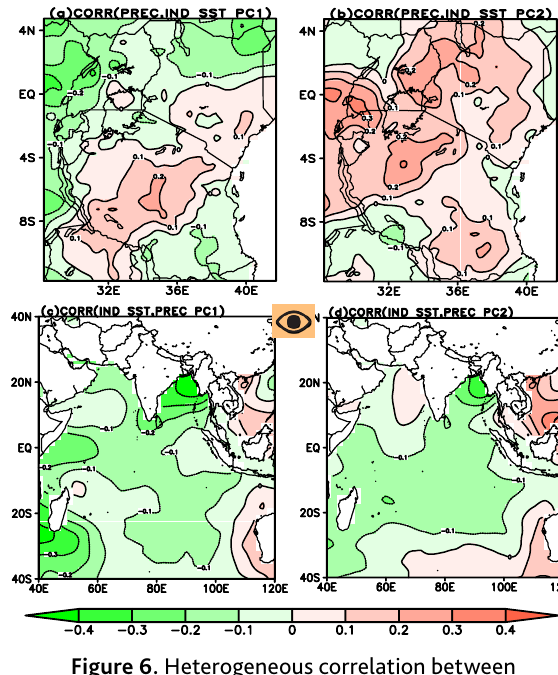
Figure 6. Heterogeneous correlation between Figure 5. Heterogeneous correlation between precipitation over the study area and PC 1 and 2 of Indian precipitation over the study area and PC 1 and 2 of SST (a and b) and heterogeneous correlation between Atlantic SST (a and b) and heterogeneous correlation Indian Ocean and PC 1 and 2 of precipitation (c and d) between Atlantic Ocean and PC 1 and 2 of precipitation (c and d) ly higher correlation values over much of the domain.